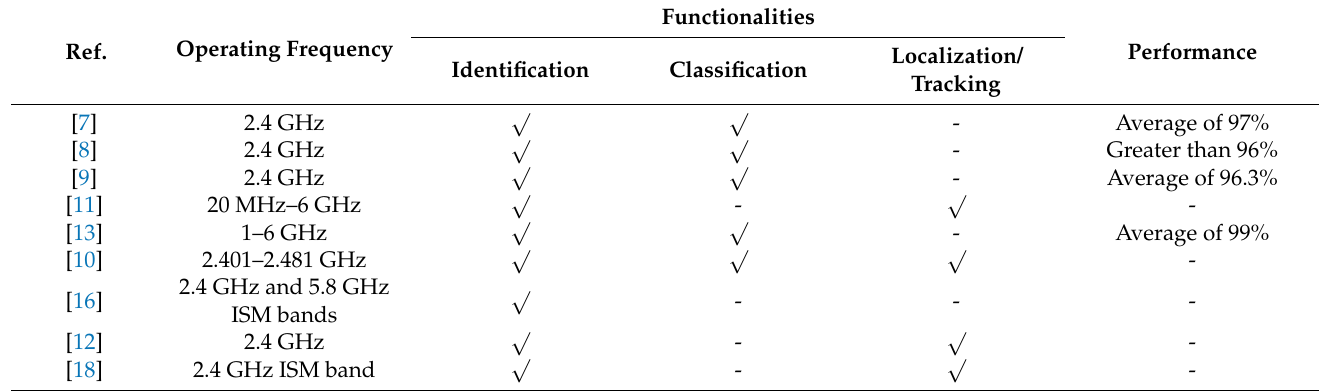
Table 2. Summary of reviewed RF-based techniques for UAV